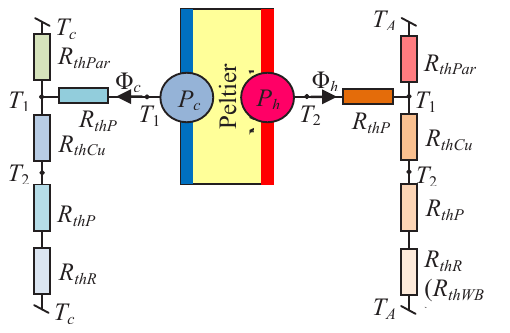
Fig. 2. Thermal equivalent circuit of cooling/heating system .